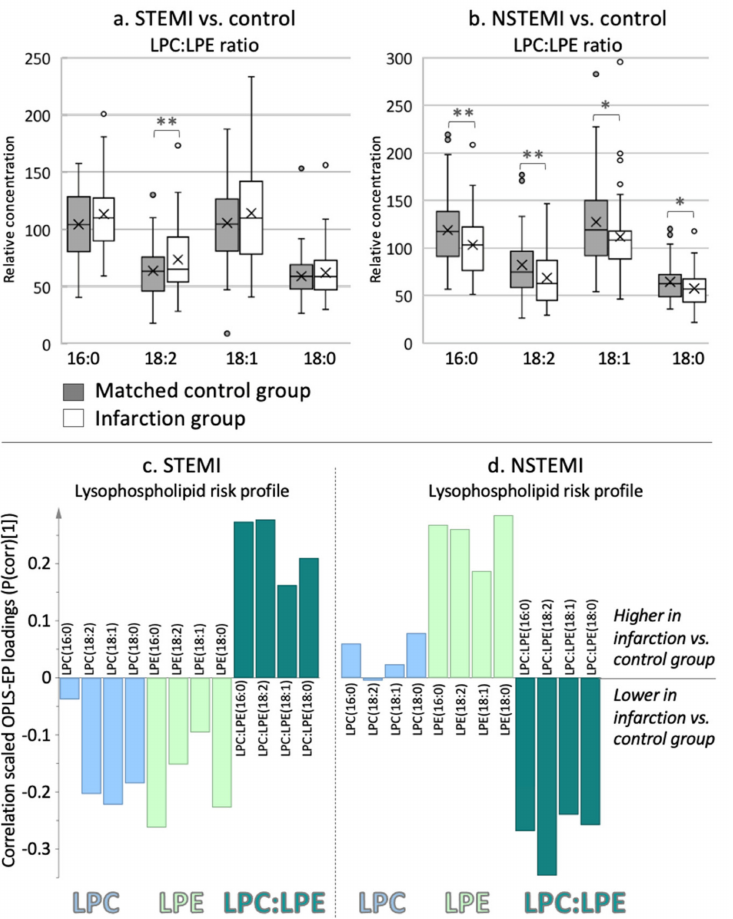
Figure 2. Raw data describing the relative concentration of lysophospholipid ratios with differ- ent fatty acid composition. ( a ) STEMI patients (white bars) and ( b ) NSTEMI patients (white bars) compared to their respective controls (grey bars). LPC, lysophosphatidylcholine; LPE, lysophos- phatidylethanolamine. ** Ratios that are significantly altered between cases and controls in multivari- ate models and univariate t tests. * Ratios that are significantly altered only in univariate analysis based on a 95% confidence level. Confidence intervals are calculated on a 95% confidence levels using Student’s t-test. ( c ) The higher LPC:LPE ratios in STEMI are caused by lower LPCs and especially LPEs. ( d ) Lower LPC:LPE ratios in NSTEMI are caused by higher LPEs and no difference in LPCs compared to matched controls (CV-ANOVA p <